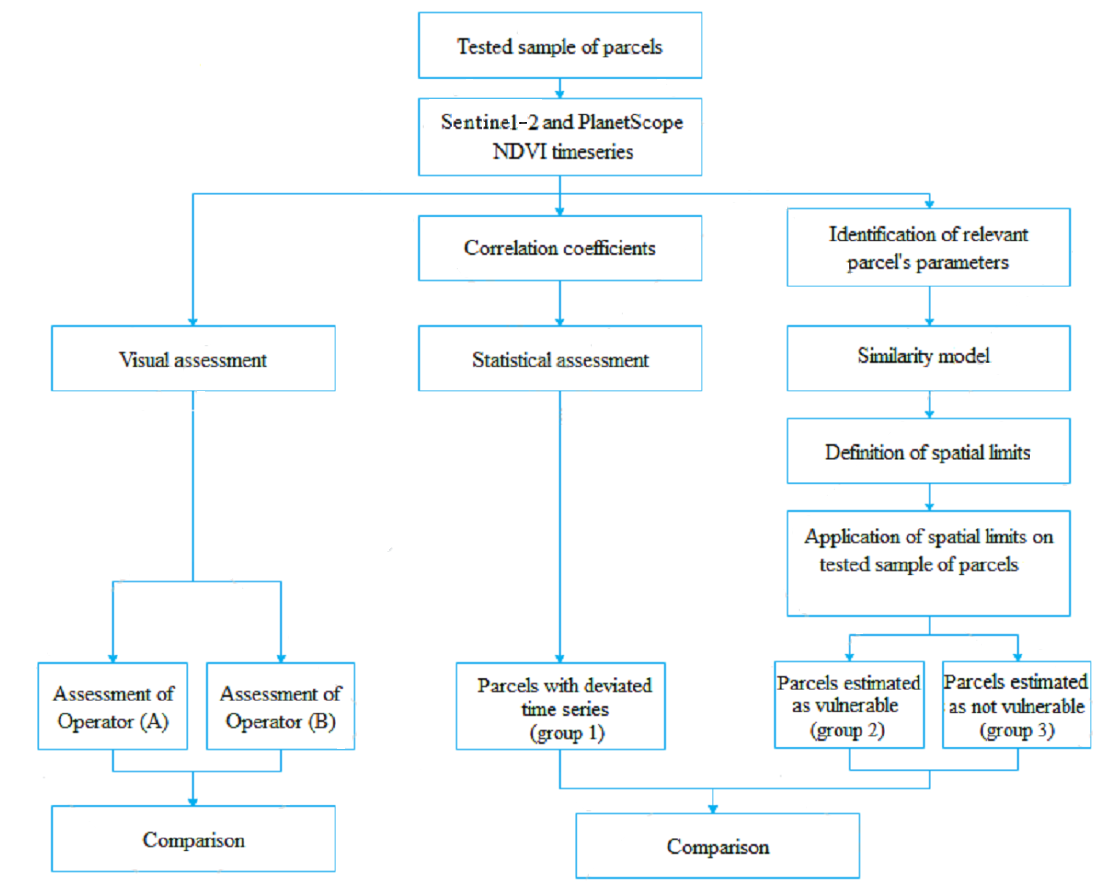
Figure 6. Workflow of the methodology.